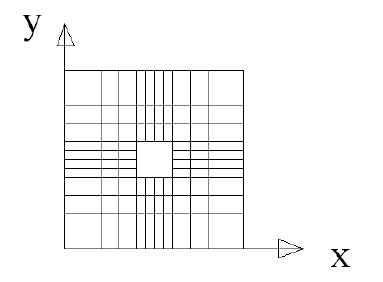
Figure 4: Typical 10x10 non-uniform mesh arrangements drawn to scale